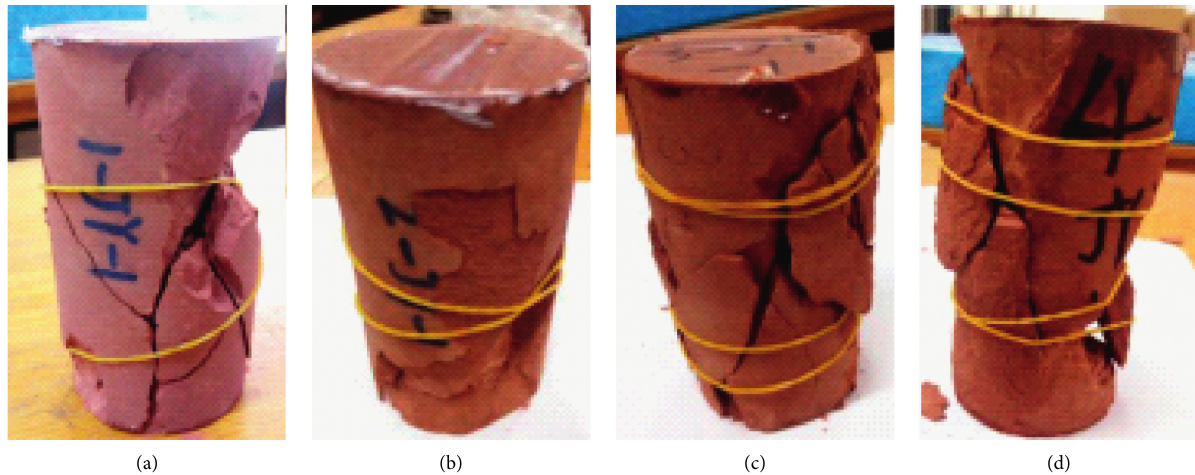
Figure 6: Failure modes of uniaxial compression for samples with different freeze-thaw cycles. (a) 0 cycle, (b) 10 cycles, (c) 20 cycles, and (d) 30 cycles.